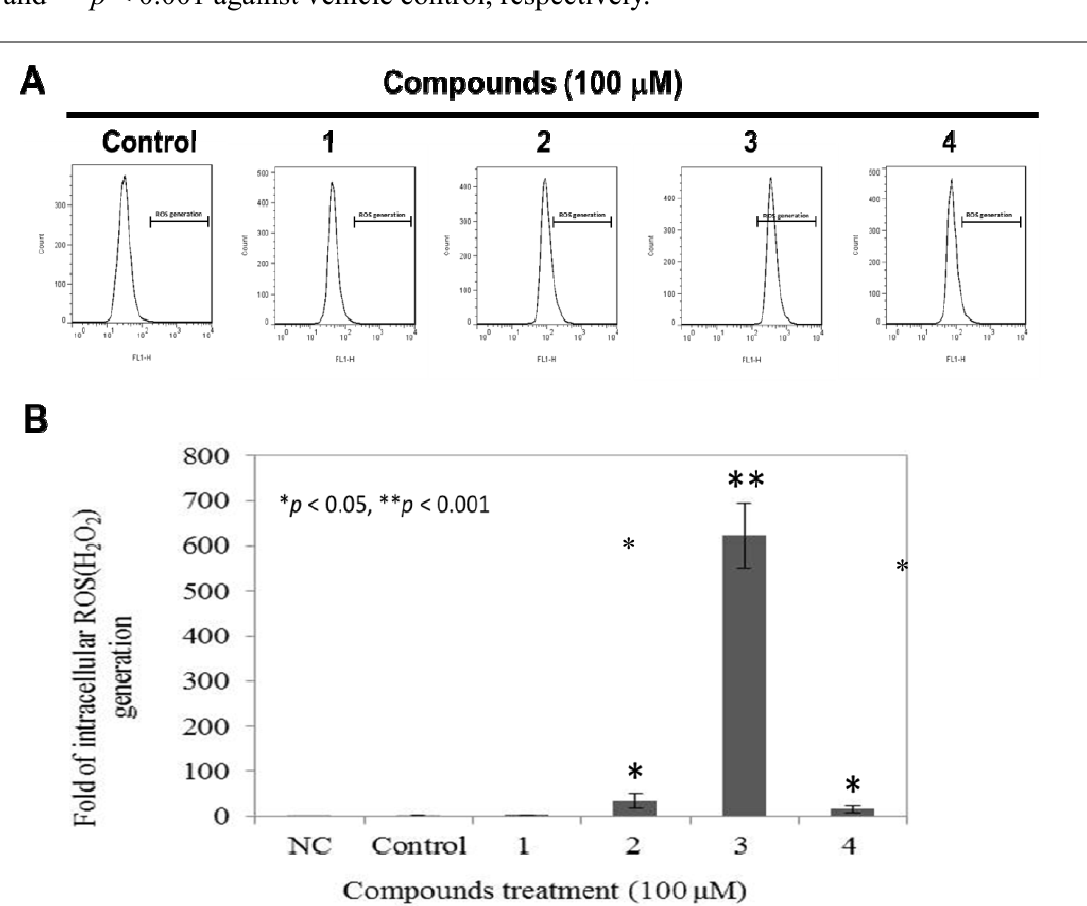
Figure 5. Modulations of endogenous ROS in A375.S2 cells by L. tulipifera compounds. 1 × 10 5 of A375.S2 cells were seeded onto a 6-well plate and treated with or